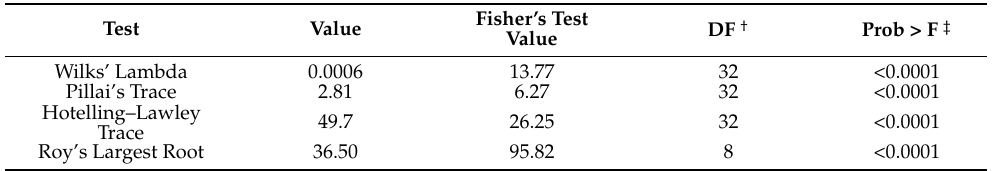
Table A1. Factors of multivariate tests to verify the significance between the different cultivars by discriminant analysis procedure.